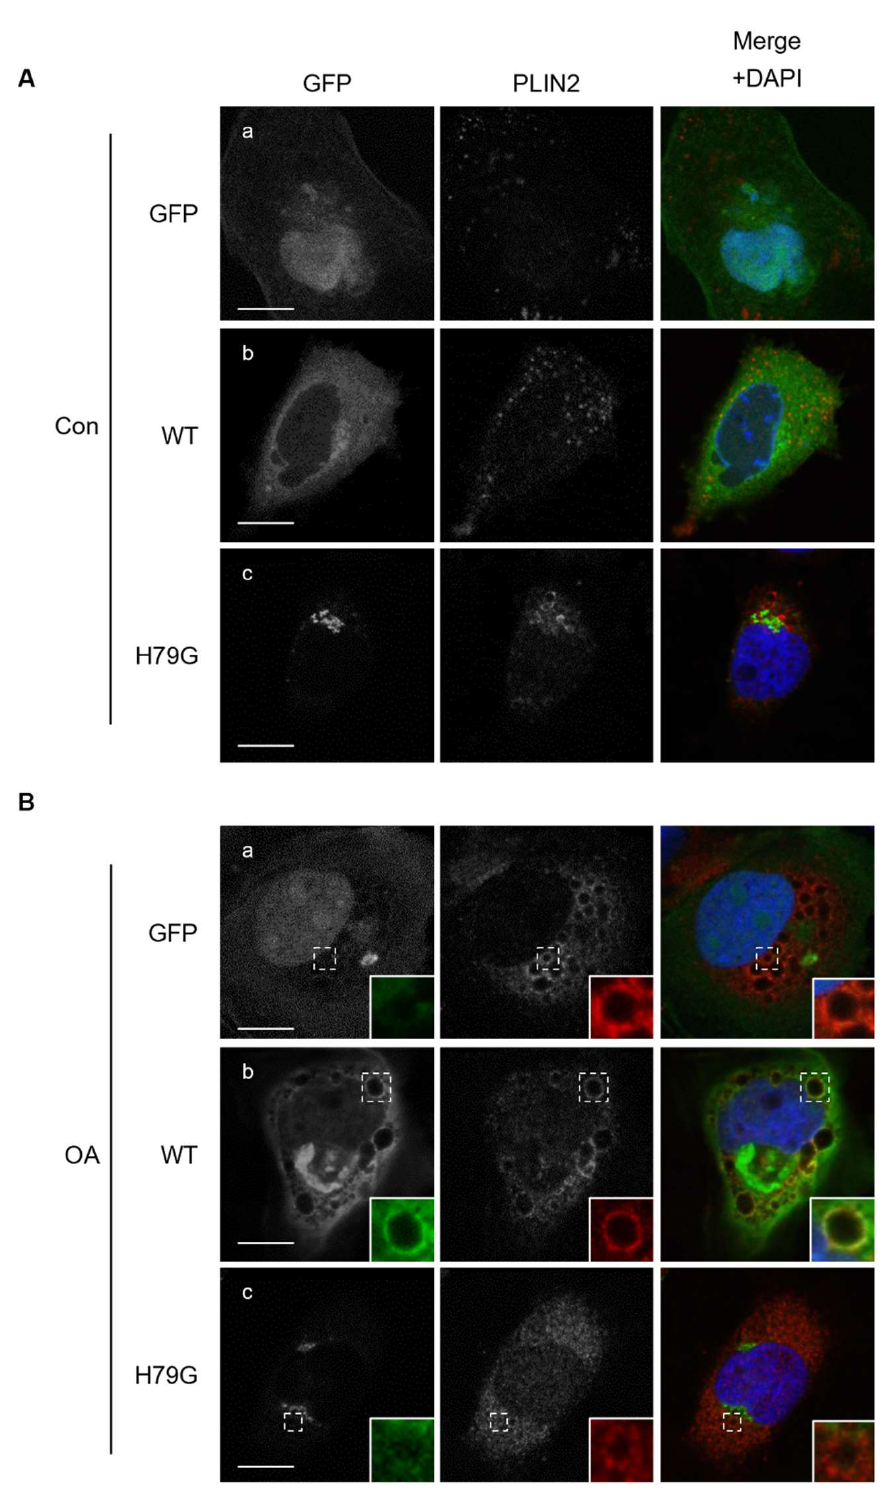
Figure 4. Partial colocalization between PLIN2 and GFP-Sar1b WT in lipid droplets. HuH7 cells transiently expressing GFP ( a ), GFP-Sar1b WT ( b ), GFP-Sar1b H79G ( c ) were treated with ( B : OA) or without ( A : Con) 0.5 mM oleic acid for 24 h. The cells were stained with the antibody against PLIN2 and DAPI. Boxed areas are shown in higher magnification in the insets. Bar, 10 µ m. Data are representative of experiments repeated more than three